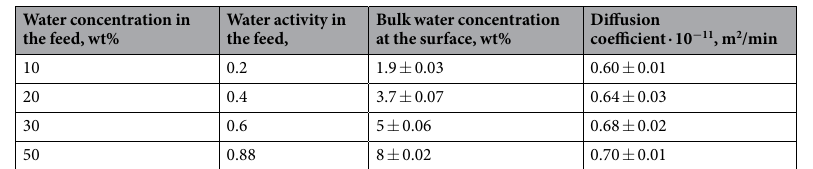
Table 2. The bulk water concentration at the surface diffusion coefficients of water in pervaporation for PAIU